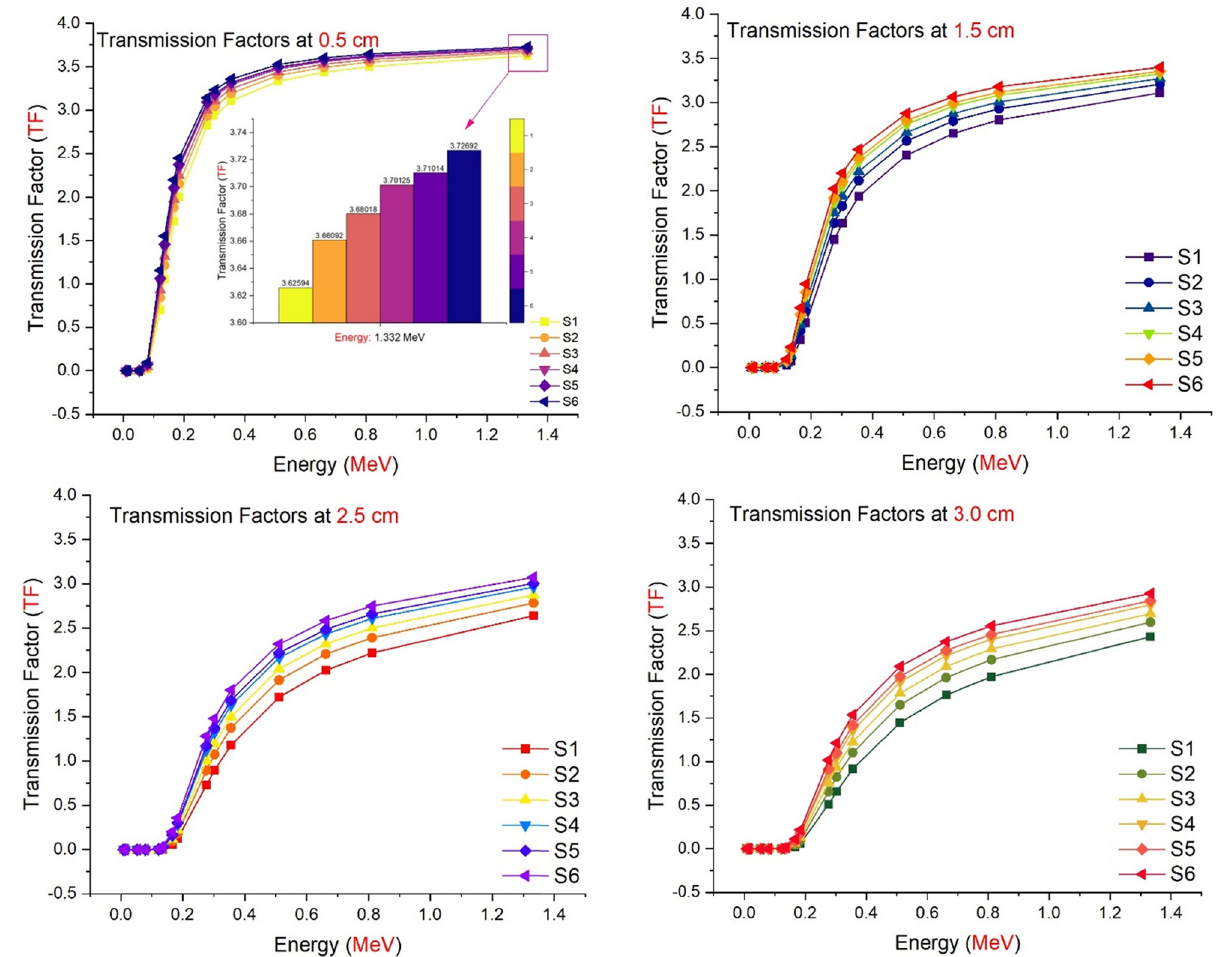
Figure 10: Comparison of the TFs as a function of used radioisotope energy ( MeV ) for di ff erent glass